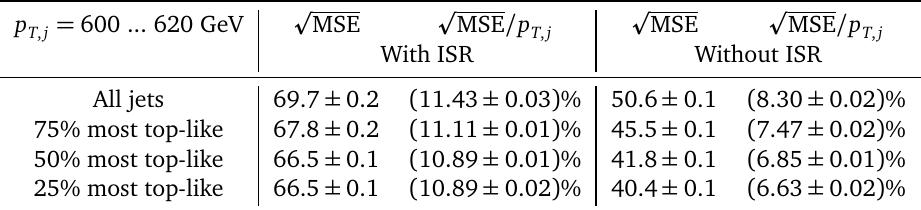
Table 1: Performance of p ation of 5 trainings. The narrow p training